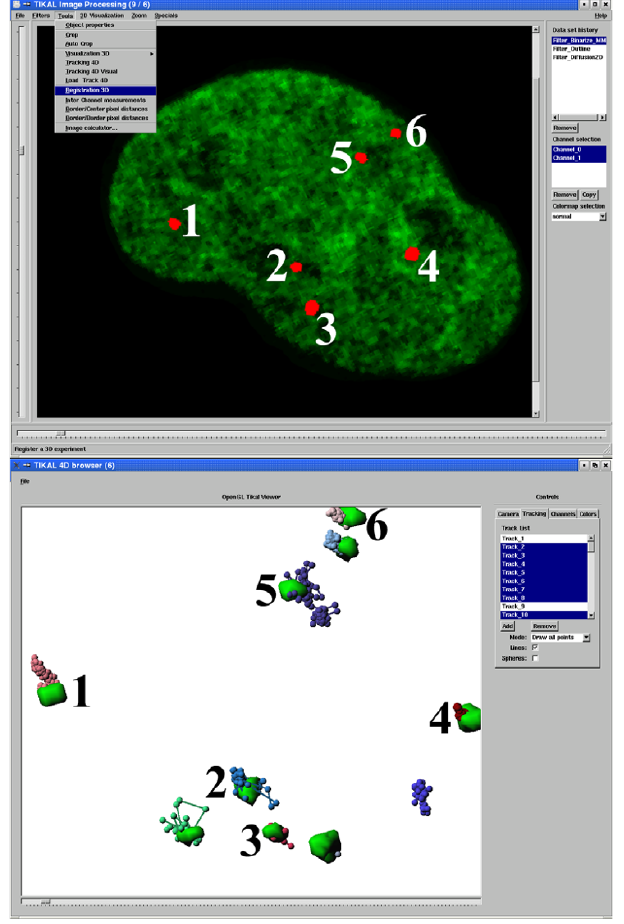
Figure 2 Screen shot of the image processing platform TIKAL. (top) Image shows a sample two-dimensional section through a nucleus with binarized nuclear particles (red) counterstained with Hoechst 33342 stain (green). Pull down menu exempli- fies different tools for quantitative analysis integrated into TIKAL. Numbers indicate different nuclear particles recon- structed by 3D isosurface reconstruction (bottom). Com- puted tracks of nuclear bodies over time are displayed as spheres on a string in the multi-dimensional scene